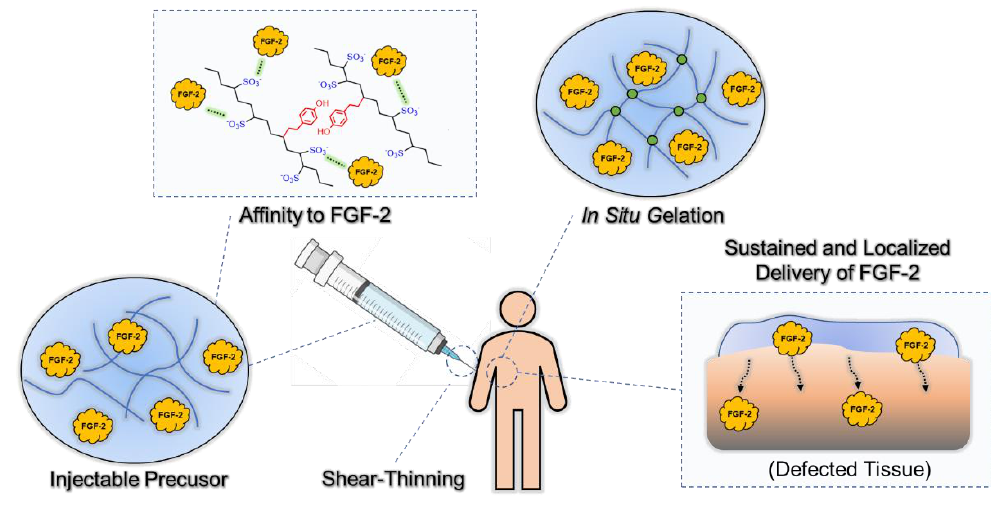
Figure 1. Concept of this